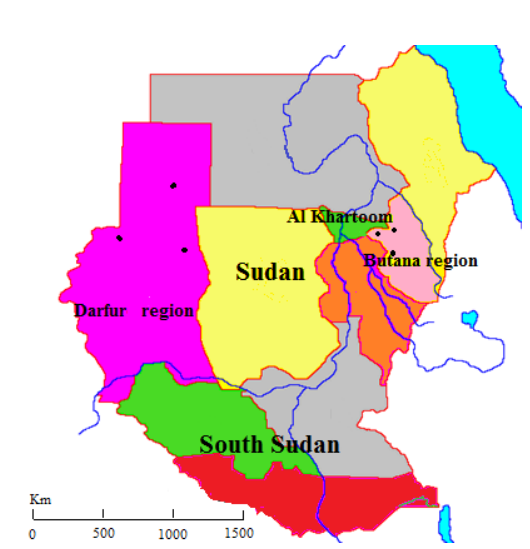
Figure 1. Regions where the study samples were